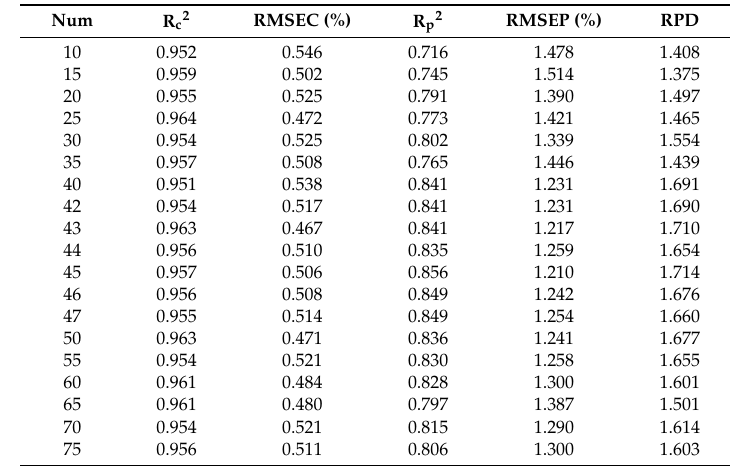
Table 3. Re-calibration of total soluble solid content for Ruby Seedless when standardization samples were removed from calibration set and model transfer performances using linear interpolation-PDS